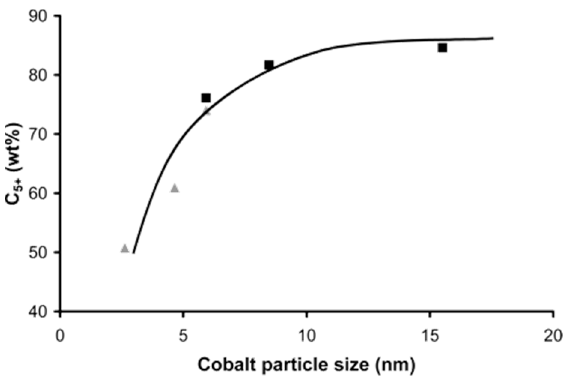
Figure 12. The influence of cobalt particle size on the C 5 + selectivity. Reprinted with permission from [86]. Copyright (2009) American Chemical Society (ACS), Washington, DC, America.